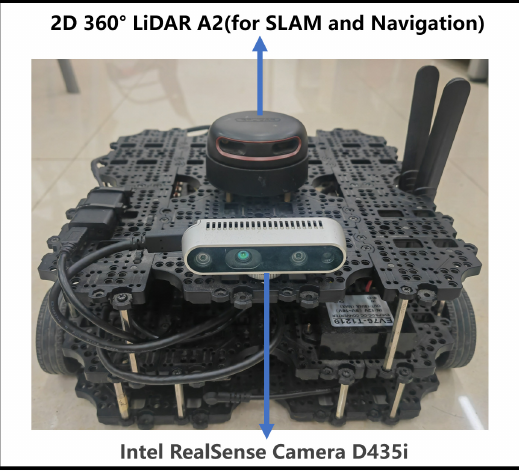
Figure 15. Turtlebot3 waffle pi.